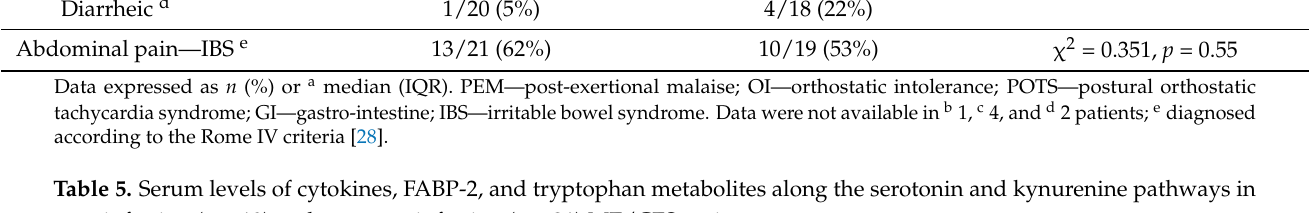
Table 5. Serum levels of cytokines, FABP-2, and tryptophan metabolites along the serotonin and kynurenine pathways